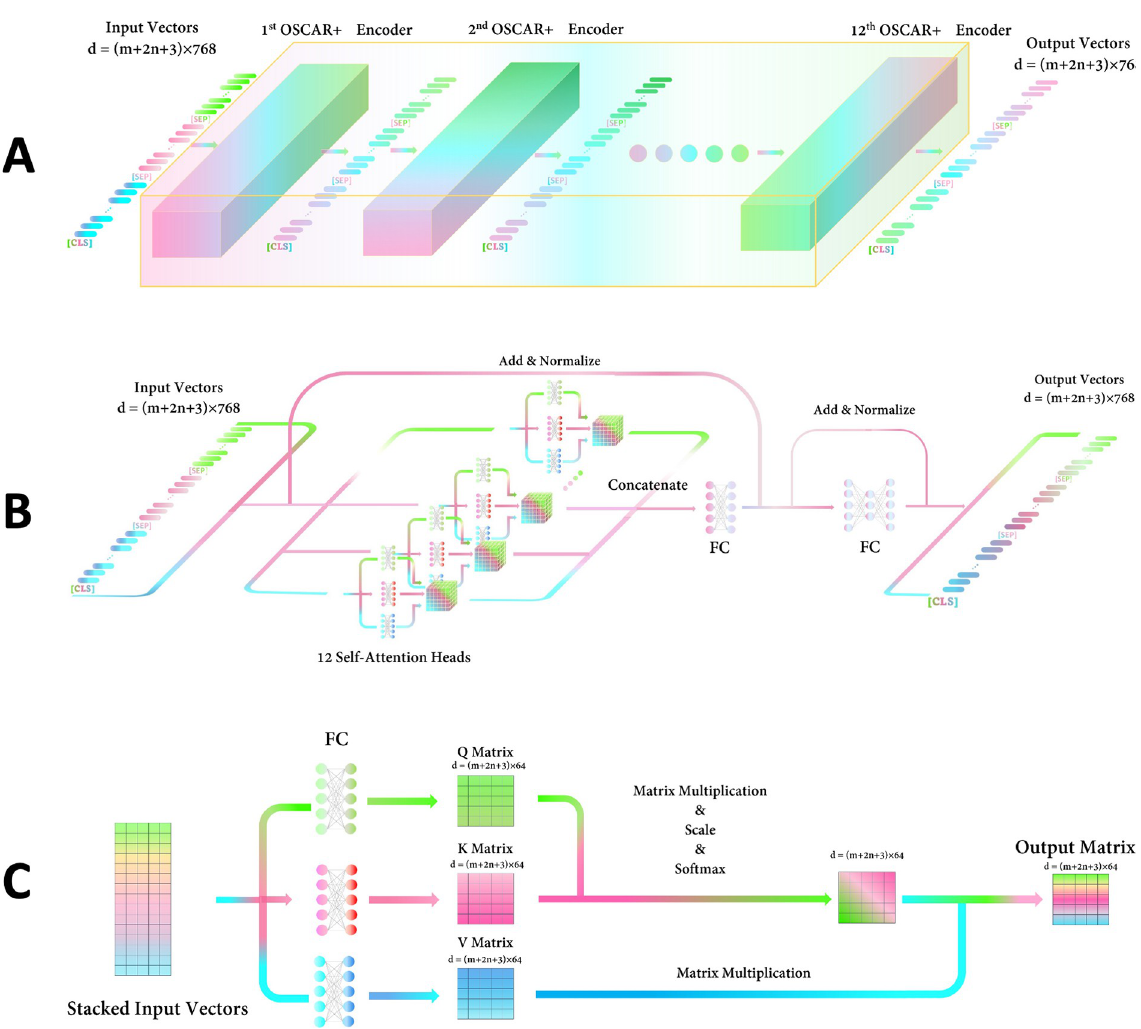
Fig 4. Architectures of OSCAR+ and its encoder. A. OSCAR+ consists of 12 tandem encoders; B. the architecture of an encoder; C. structure of the self-attention